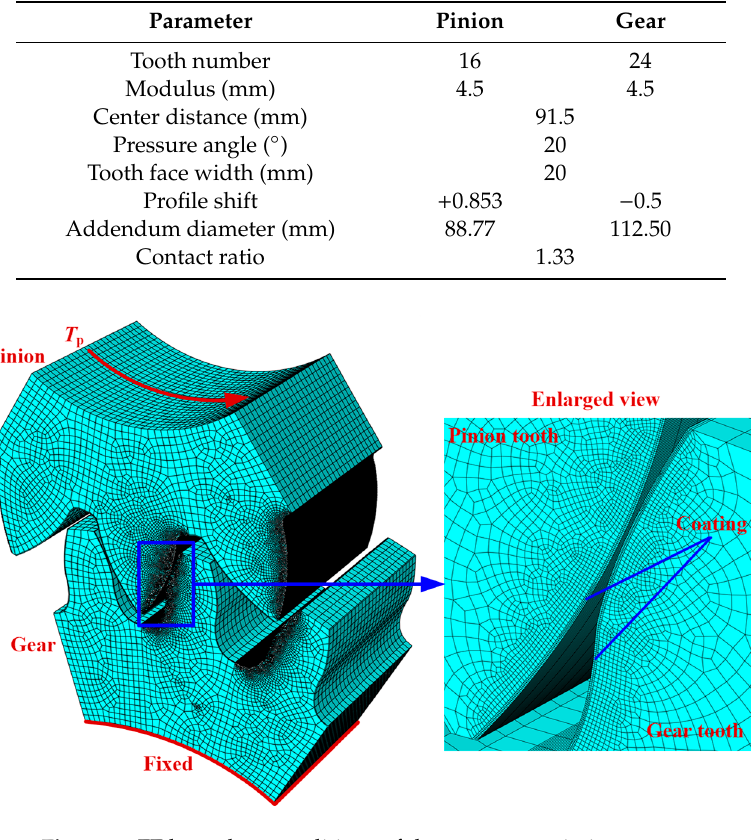
Figure 3. FE boundary conditions of the gear transmission system.